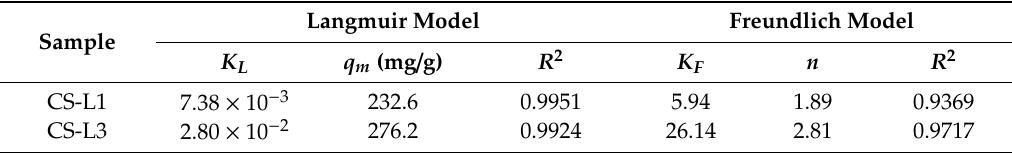
Table 4. Isotherm dates for Cu(II) adsorption onto the CS